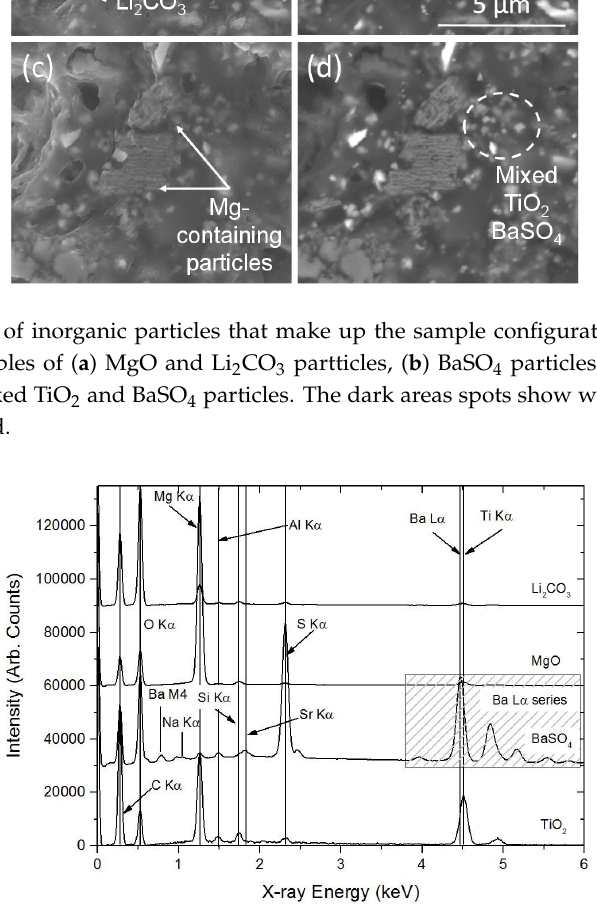
Figure 4. Typical X-ray spectra for the different inorganic components of the primer system. The arrows either point to that indicated the elements positions or sit above them. It can be seen that for each compound, there is some level of “contamination” due to sampling volume effects or small particles. This is most evident for the small TiO 2 particles that show significant Mg levels as well as S, Ba and a little Al.